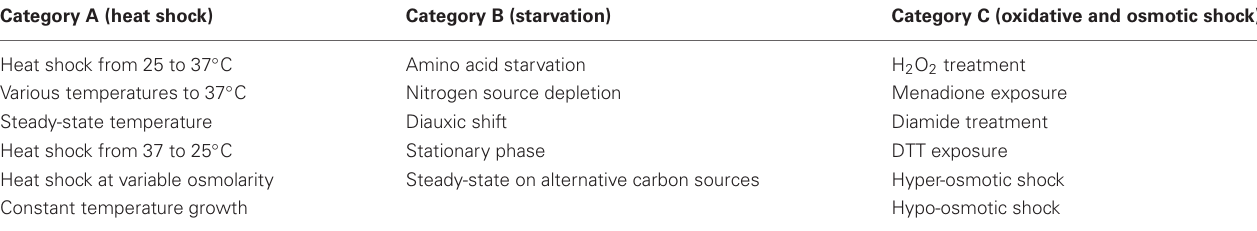
Table 1 | Stress conditions organized into three categories.